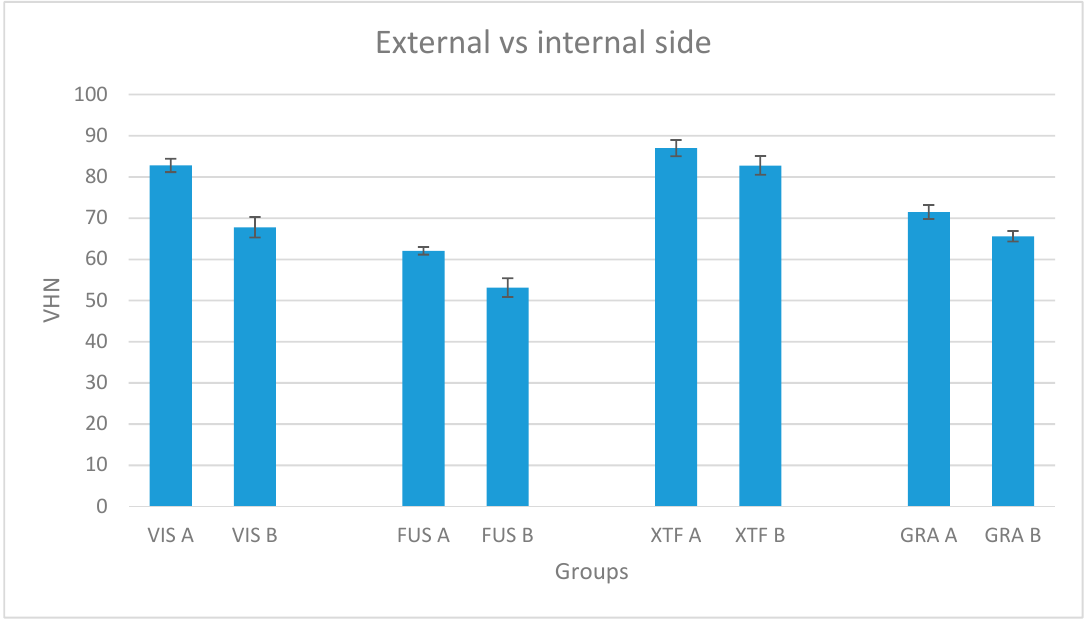
Figure 2. Mean Vickers hardness number and standard deviation for each tested material, considering both the external and the internal side of the samples. A: External side; B: Internal side.